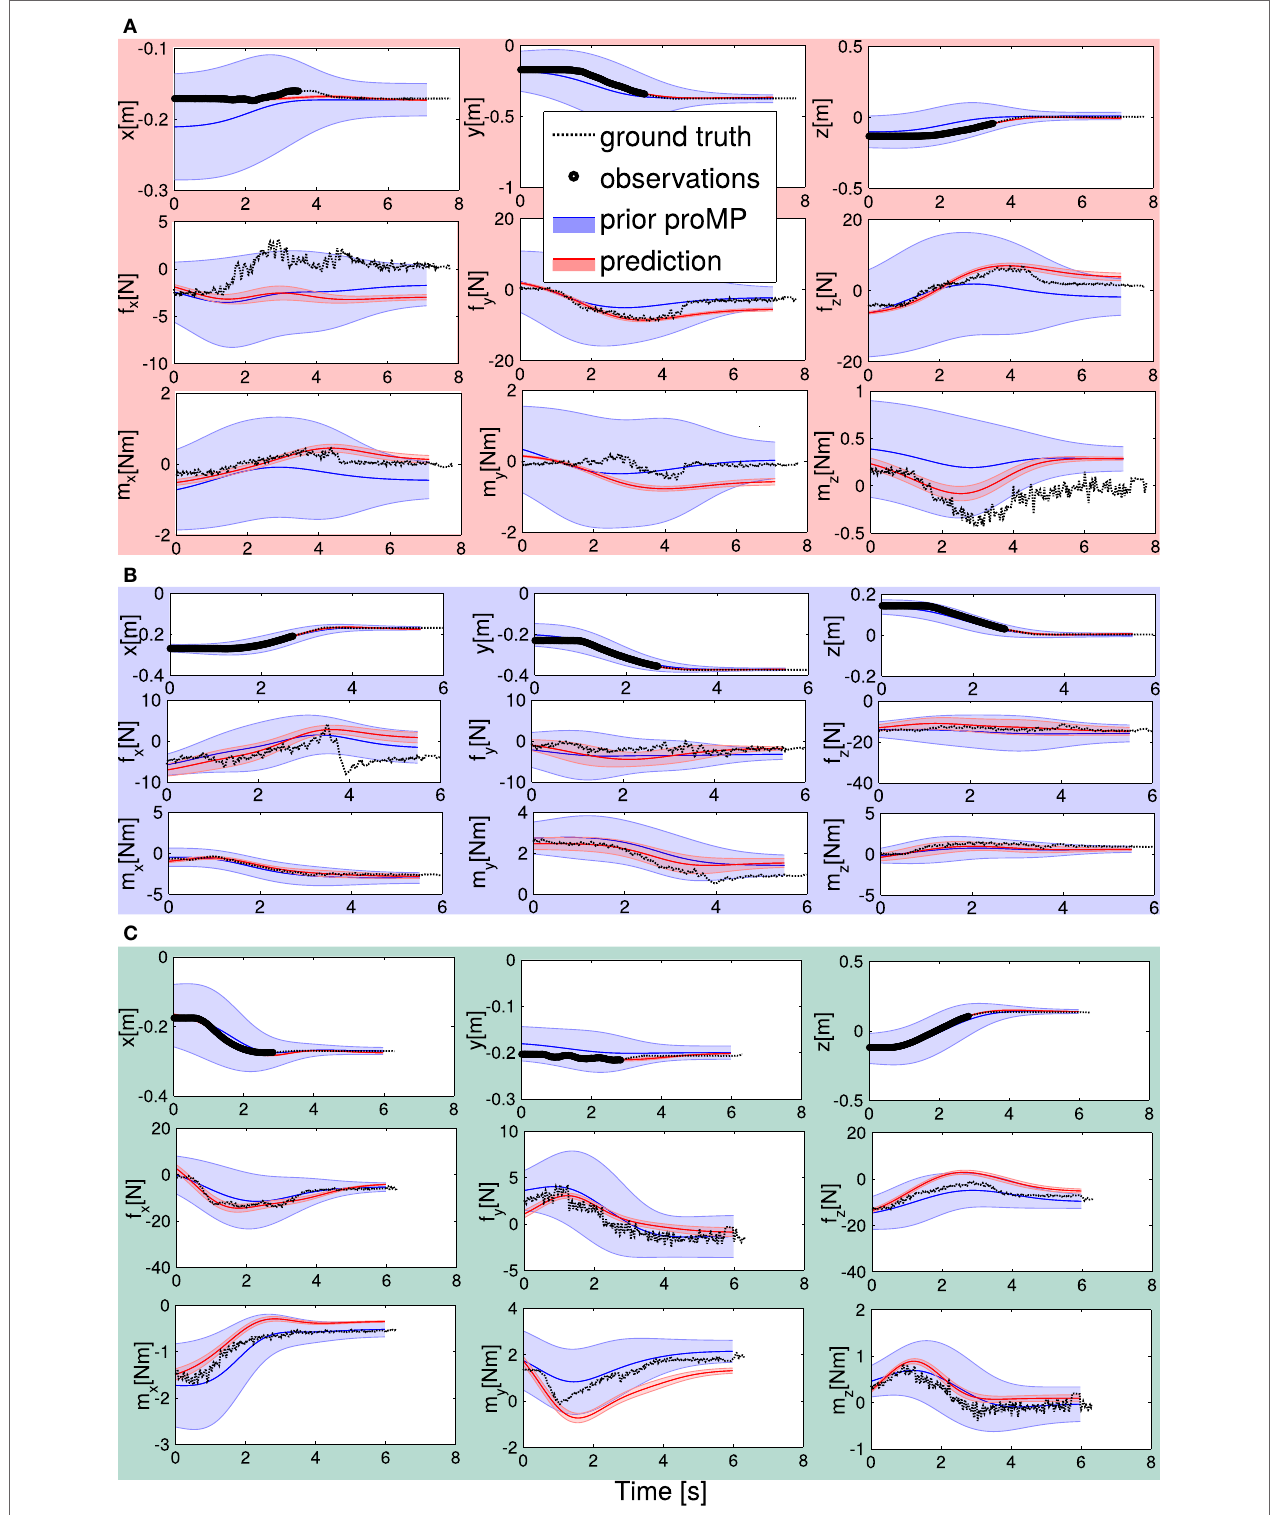
FIGURE 12 | The prediction of the future trajectory from the learned ProMPs computed from the position information for the 3-targets dataset on the real iCub ( Figure 11 ) after 40% of observations.